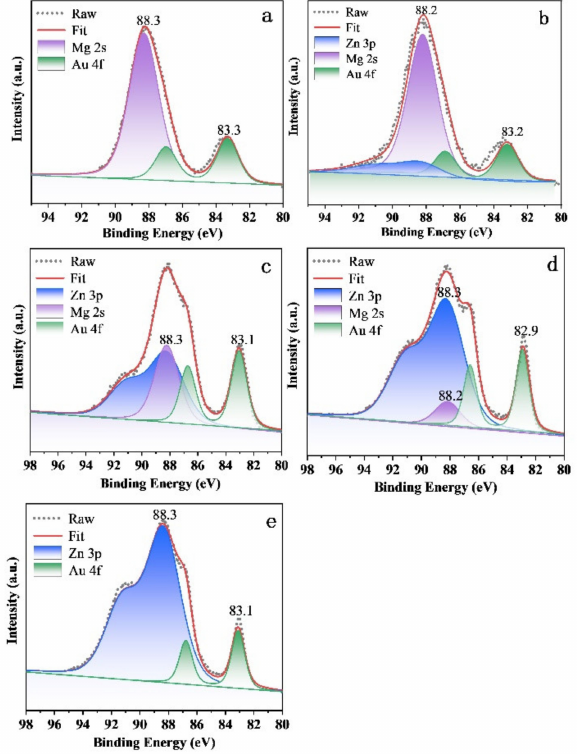
Figure 5. XPS Spectra of Au 4f-Zn 3p-Mg 2s of Zn-Mg-Al oxides-supported gold catalysts: ( a ) Au 25 /MgAl-400; ( b ) Au 25 /Zn 0.05 MgAl-400; ( c ) Au 25 /Zn 0.33 MgAl-400; ( d ) Au 25 /Zn 3 MgAl-400; ( e ) Au 25